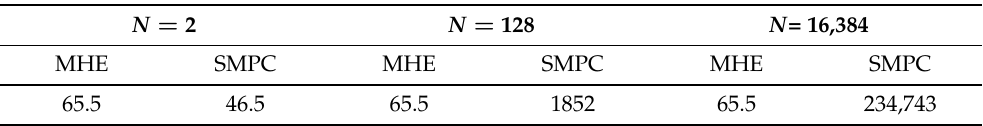
Table 1. Communication overhead (MB) of performing a batch of N divisions where numerators and denominators are randomly chosen from [ 1,1 × 10 4 ] .